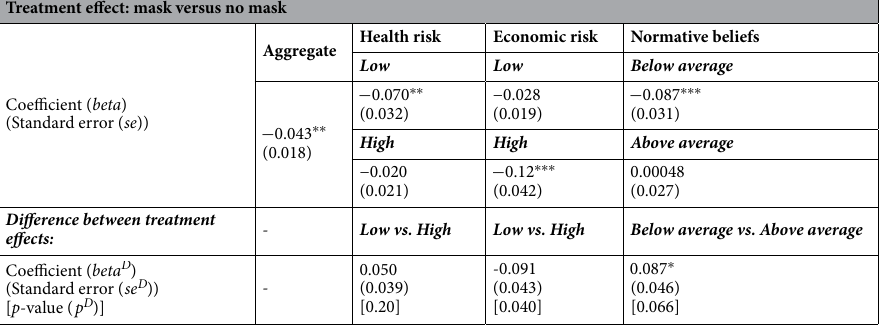
Table 1. Summary of estimates. Notes: To empirically estimate the treatment effect T , we use a linear probability specification: Y is = α s + β T is + γ X is + ǫ s , where Y is is the dummy for following advice for individual i in state s . To estimates the difference in treatment effects by group, we interact the group variable of interest with the treatment dummy. Standard errors (in brackets) are clustered at the state level. The stars indicate significance: * p < 0.100 ** p < 0.050 , and *** p < 0.010 . For the main treatment effect, X is includes design controls , such as the suggested option during the experiment, and the order of the experiment and the survey questions about normative beliefs; demographic controls , such as gender, race, and education; normative beliefs and COVID-related risk covariates , including the composite index for health risk measured as 1 for older respondents (age greater than 50) or respondents who have reported fair or poor health conditions. Both of these factors mean that this group has a higher health risk and composite index for economic risk, measured by the respondent reporting a transition to unemployment or reduced work hours between January and July/ August for the household. For the differences in treatment effects by group, we include all the controls except for the group variable of interest. We also provide the coefficient, standard errors (in brackets), and the p-value ( p D ) for the difference in treatment effects by group mentioned in the header [in square brackets]. For all the columns, the sample size = 1867 (with N = 906 in the control condition and N = 961 in the treatment condition). See Appendix Table S4 and Appendix Table S5 for the full